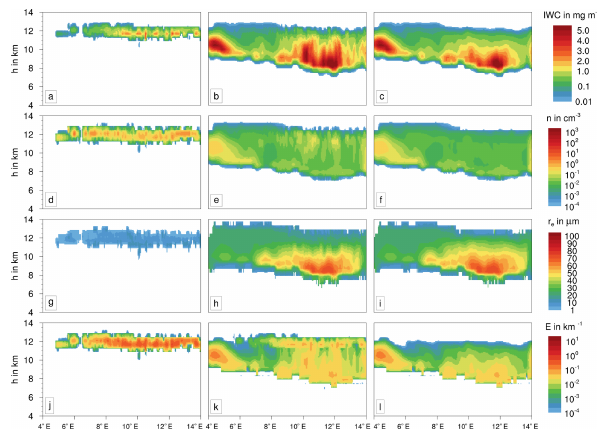
Figure 7. Vertical cross section of various contrail properties at 12:00UTC along the black line in Fig. 4: ice water content, ice crystal number concentration, effective radius, and extinction coef- ficient (from top to bottom). Depicted are the simulation with avia- tion (left column: contrail ice class; middle column: cirrus ice class) and without aviation (right column).